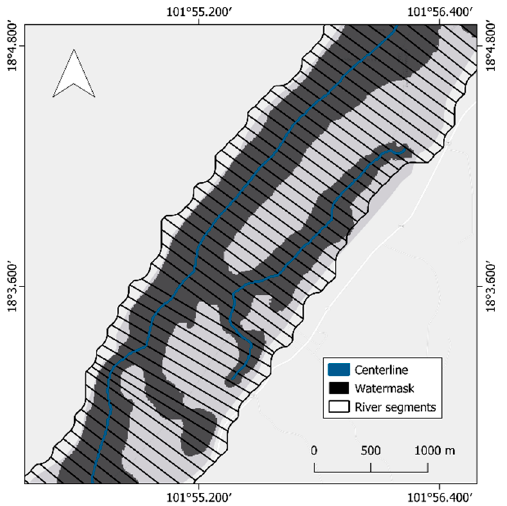
Figure 11. Two centerlines calculated from RivWidth tool based on the water mask. The assigned river width for a river segments with two centerlines is the sum of both.